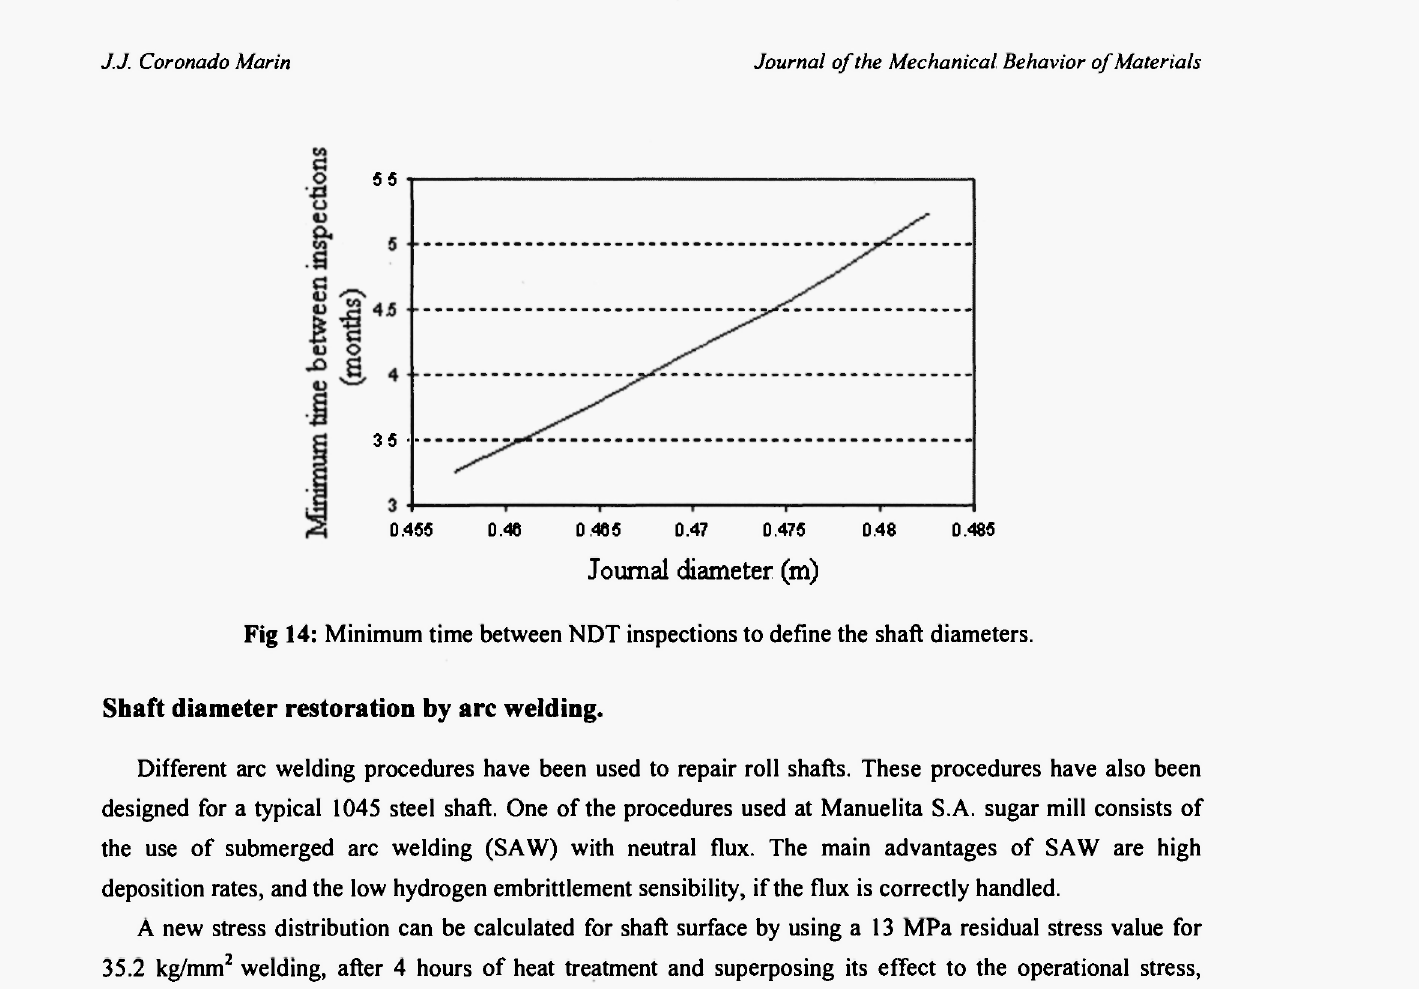
Figure 15. Making use of the equation presented earlier in this paper, using Ki equivalent and equaling it to the Kic of the material, the critical depth of a crack was calculated. The calculated critical crack size was 60 mm for semielliptical and 35 mm for circumferential cracks. Using these crack sizes, a maximum time between NTD inspections of 110 days was required. The minimum detectable crack size considered was 4 The same repaired shaft without stress relieving was considered. Residual tension welding stresses of 170 MPa for 35.2 kg/mm 2 welds were superimposed on operational stresses for the shaft. Residual stresses acting all around the repaired zone were assumed. The stress distribution can be observed in Figure 16. The calculated critical crack size was 9 mm for semielliptical and 8 mm for circumferential cracks. Using these crack sizes, a time between NDT inspections of 40 days was required. Calculated inspection periods can be extended by 18% if a minimum detectable crack size (depth) of 3 mm is considered instead of 4 mm used in these calculations. The service life can be reduced by an estimated 63% when the stress relief is not